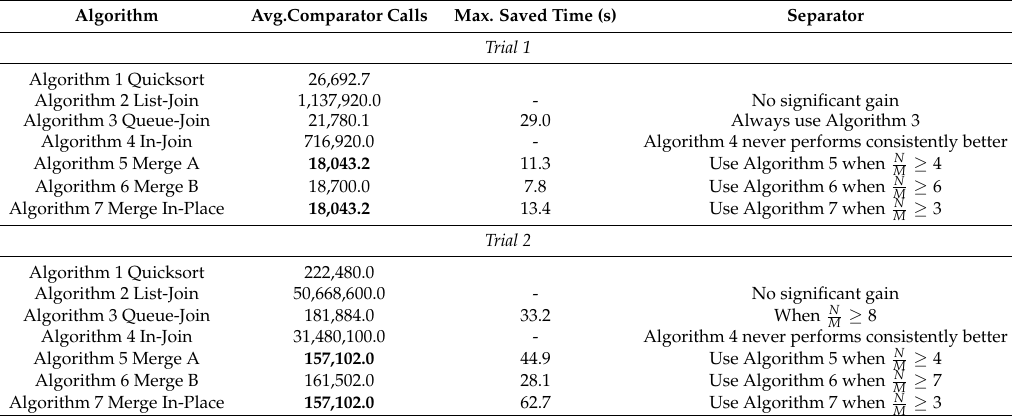
Table 3. Maximal runtime gain of Algorithms 2–7 compared to Algorithm 1 for randomized uniform Trial Sets 1 and 2. The number of comparator calls was averaged over all data points, ignoring separators. Separators indicate where an algorithm becomes superior to Algorithm 1. Separators for runtime gain can operate solely on the total length of the input list N and the number of know nsorted sublists M . They are estimated to the nearest integer for linear separation and to two decimal places for logarithmic separation, in both cases assuming the simplest form without any offset